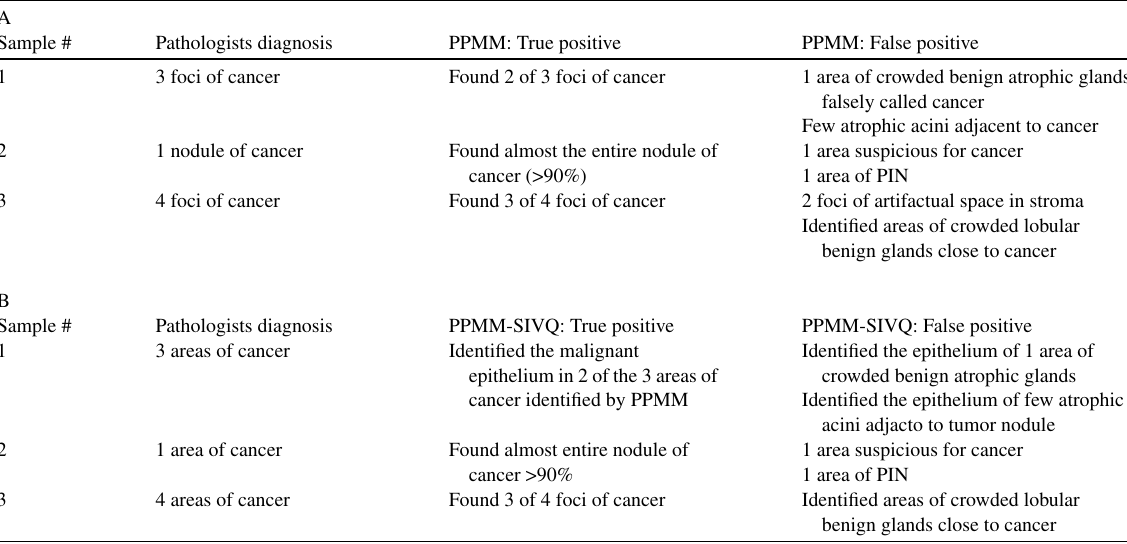
Qualitative summary of the results from the PPMM vs. PPMM-SIVQ